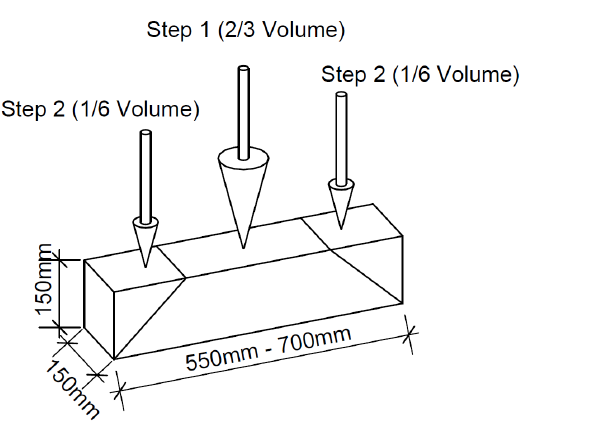
Figure 1. Preparation of samples according to standard EN 14651, the casting is performed in two steps, arrows denote filling areas.